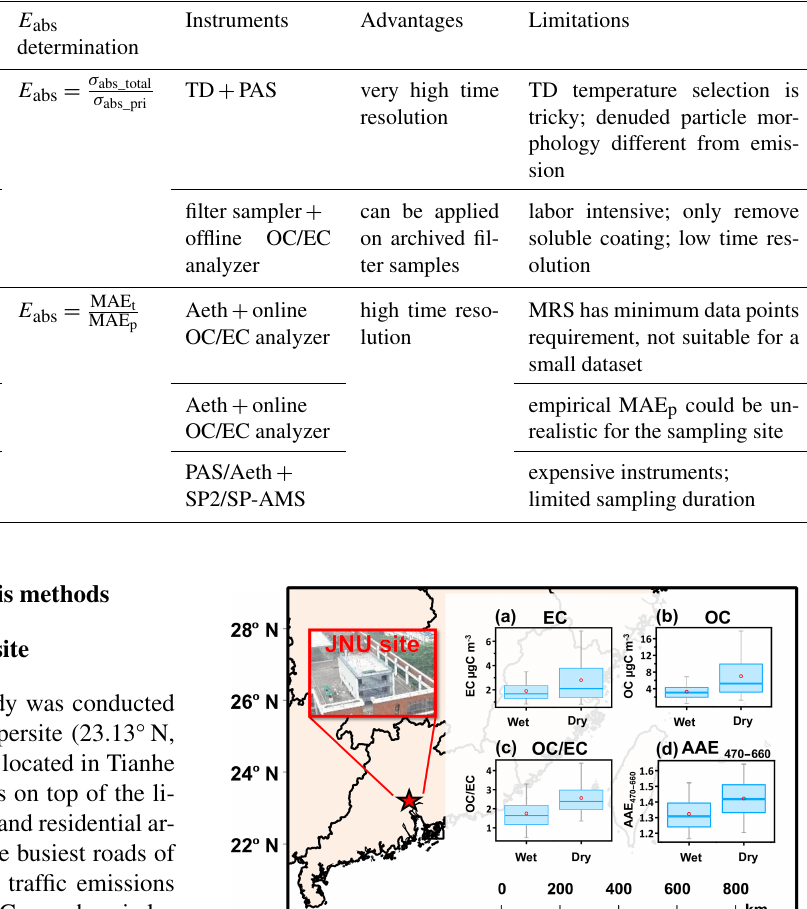
Table 1. Comparisons of three E abs determination approaches.